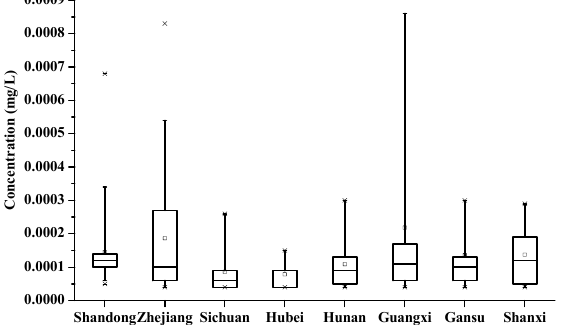
Figure 6. Boxplot of discharge concentrations of Hg from different regions WWTPs. Note: Because there was not enough data from Jilin WWTPs, so there was no boxplot for Jilin. “ (cid:3) ” stands for average value, and “ × ” stands for 95% percentiles.